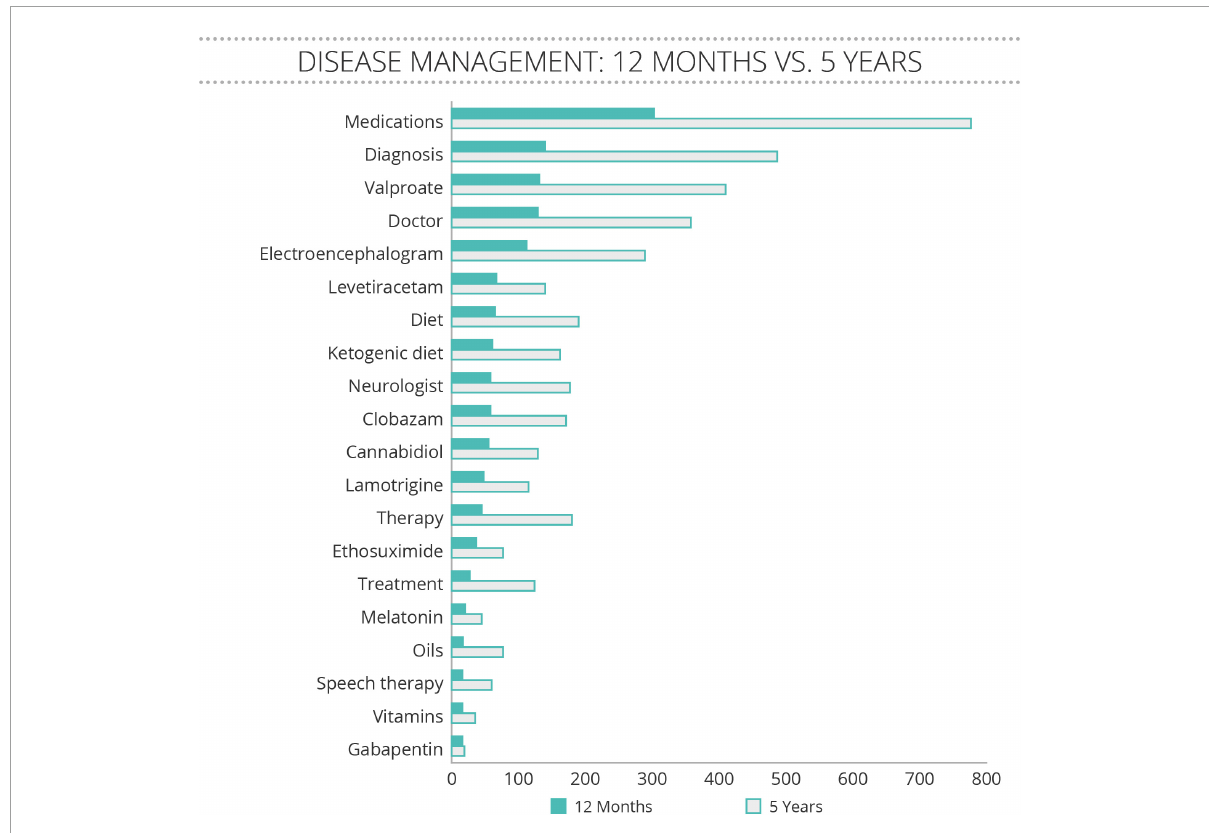
FIGURE2 Treatment terms discussed spontaneously by family members of people with SLC6A1 Neurodevelopmental Disorder (SLC6A1-NDD). Analysis for treatment terms of postings on a private Facebook group between January 2016 to February 2021, and for a 12 month period between February 2020 and February 2021. The number of mentions of concepts related to disease management revealed that anti-epileptic medications were discussed more often than any other treatment approach. “Diet” and “ketogenic diet” were ranked in the top 10 and the terms “therapy” and “speech therapy” ranked in the top